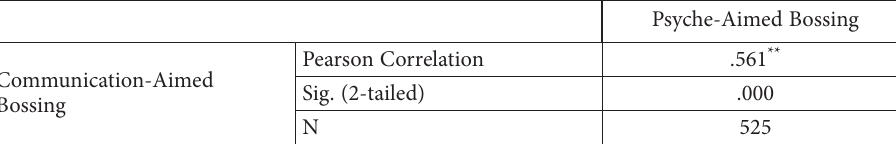
Table 4. Inter-correlation coefficient values of the BOSS methodology factors